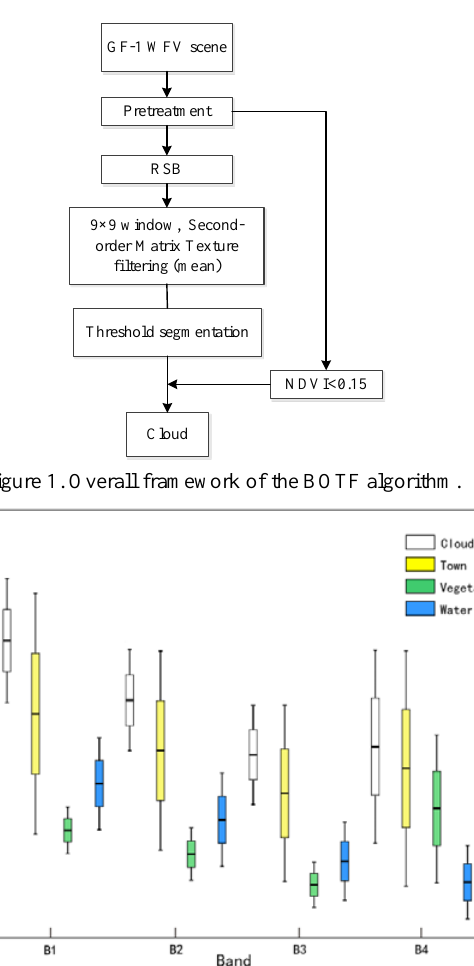
Figure 2. Distribution pattern of spectral numerical of cloud and typical objects.